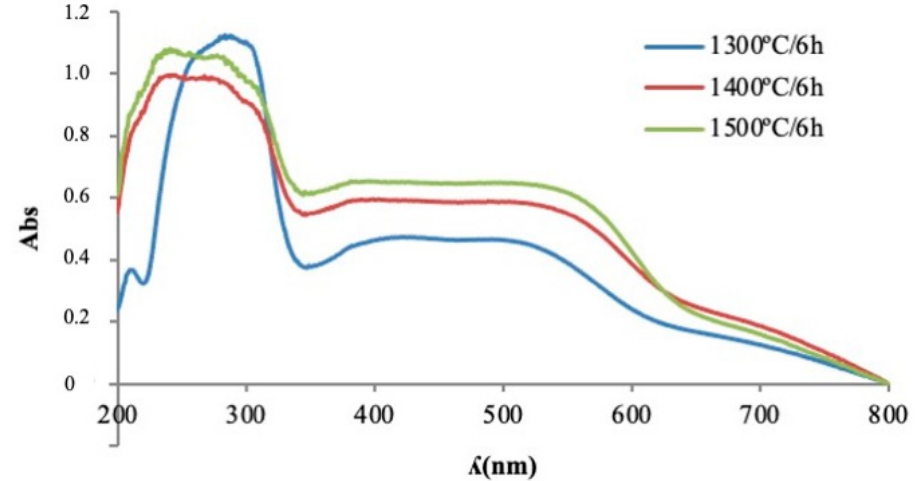
Figure 12. UV-Vis spectrophotometry of pigment Y 0.98 Al 0.98 Cr 0.04 O 3 fired at different temperatures.